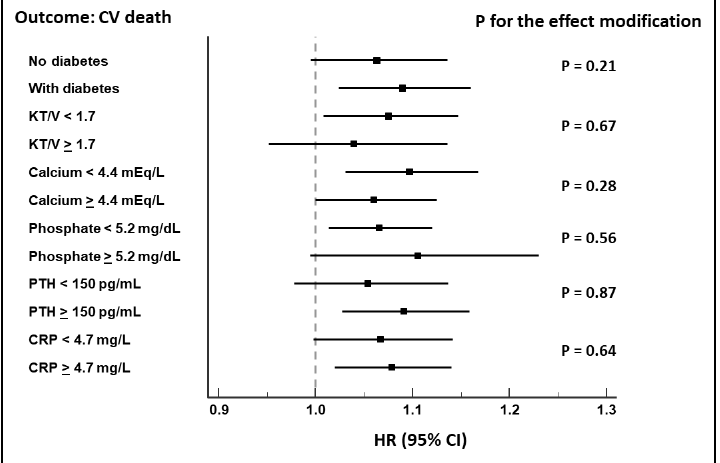
Figure 4. Cox regression analysis showing no effect modification of the considered variables on the association between diastolic changes and CV death.